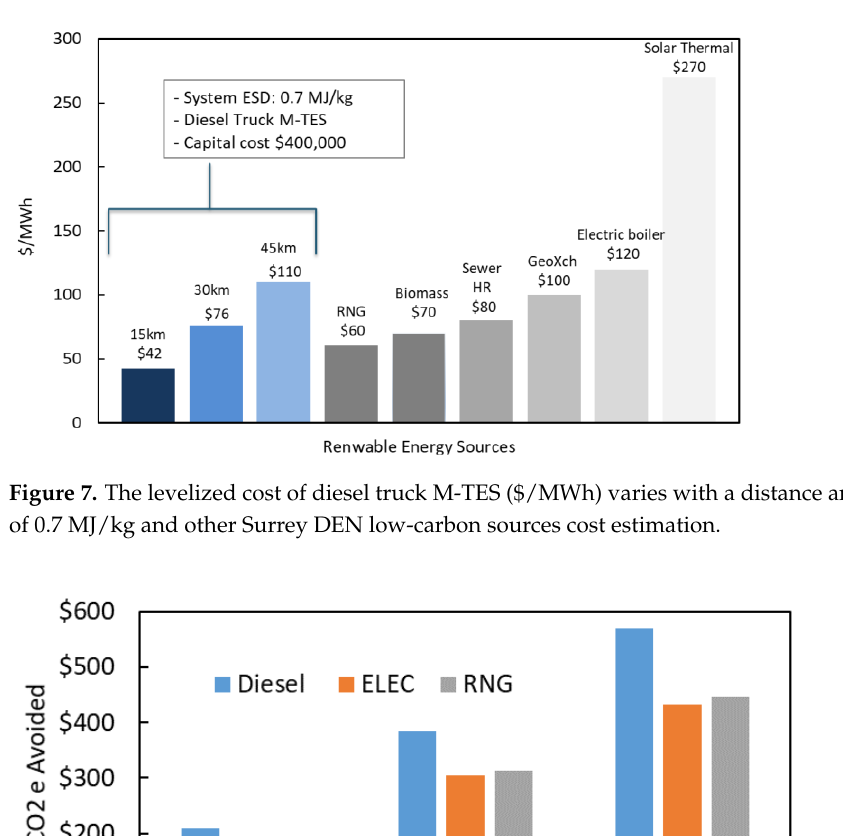
Figure 6. The M-TES levelized cost with different IWH locations and truck modes.